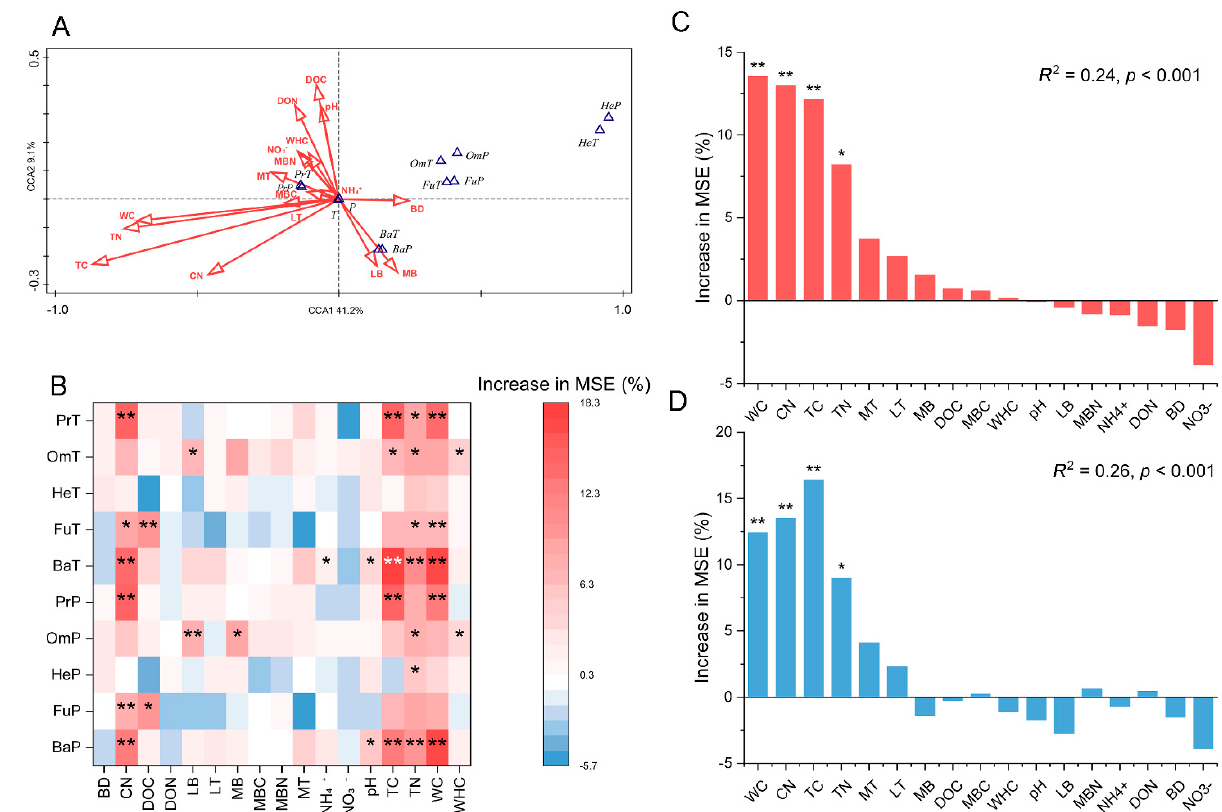
Figure 6. The relationship between environmental variables and nematode daily carbon budget and production. ( A ): Canonical correspondence analysis (CCA) of nematodes’ daily carbon used in production and budget (total and in different trophic groups) and environmental variables in subalpine spruce forests. ( B ): Percentage increases in the mean squared error (MSE) (% of increase in MSE) and significance of environmental variables for daily carbon budget and production of different trophic group nematodes. ( C ): Percentage increases in the mean squared error (MSE) (% of increase in MSE) and significance of environmental variables for daily carbon budget of total nematodes. ( D ): Percentage increases in the mean squared error (MSE) (% of increase in MSE) and significance of environmental variables for daily carbon used in production of total nematodes. * p < 0.05, ** p < 0.01.